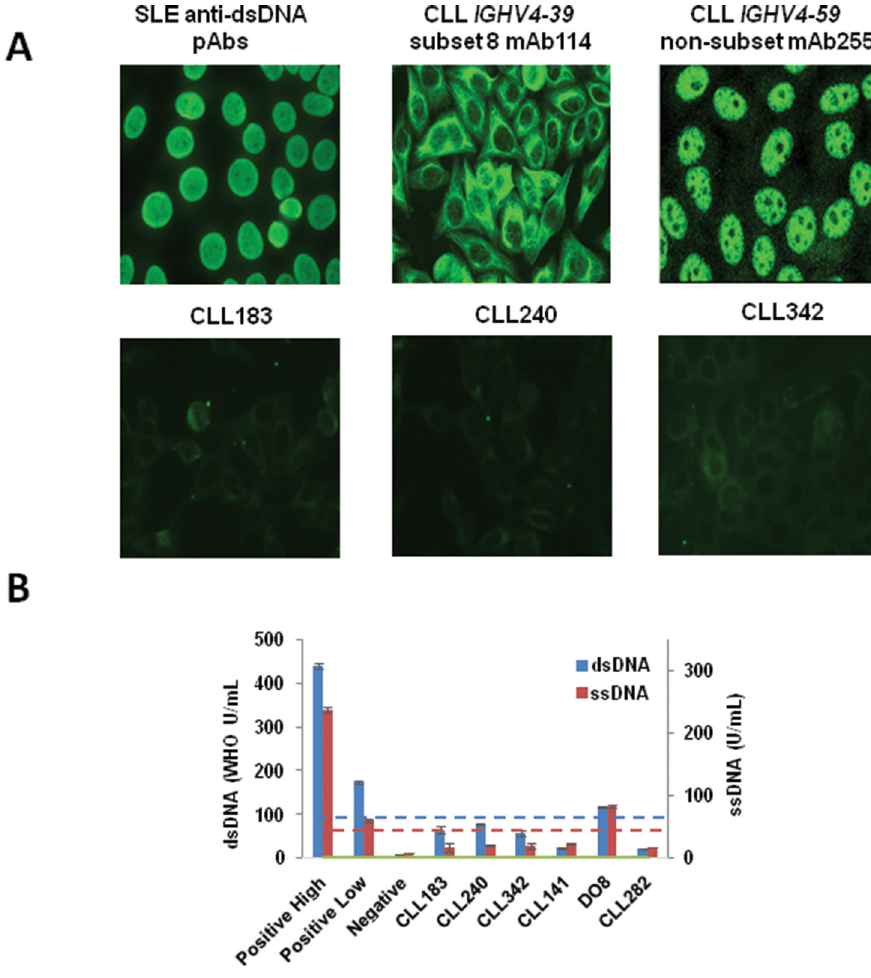
Figure 4. Binding of subset 4 IGs to permeabilized and fixed HEp-2 cells and to DNA. (A) Reactivity of subset 4 IGs with permeabilized and fixed HEp-2 cells. Binding of Abs was detected using fluorochrome-labeled goat anti-human IgG pAbs. (B) Binding of native CLL IGs to DNA determined by ELISA. IGHV4-34 + subset 4 mAbs (nos. 183, 342 and 240), IGHV4-34 + non–subset 4 mAbs (nos. 141 and DO8) and subset 2 ( IGHV3-21/IGLV3-21 ) mAb (no. 282) were tested for reactivity with dsDNA and ssDNA by enzyme immunoassay. Antibod- ies were used at a concentration of 25 ug/mL. Human sera containing antibodies reactive with dsDNA or with ssDNA were used as positive controls. Human serum without antibodies against dsDNA or ssDNA was used as negative control. Data are average ± SD of at least three independent experiments. Following the calculation and result interpretation informa- tion provided by the manufacturer, values ≥ 92.6 WHO units/mL for dsDNA binding (dashed blue line) and ≥ 68.6 U/mL for ssDNA binding (dashed red line) were registered as